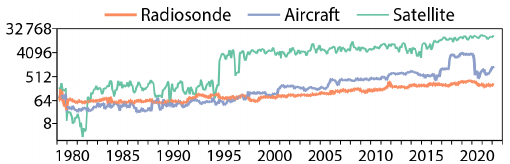
Figure 12. Monthly average number of wind observations per day from 175 to 225hPa, 10 ◦ S to 10 ◦ N and 90 ◦ W to 150 ◦ E, for March 1979 to February 2022, from radiosondes (orange), aircraft (blue) and satellites